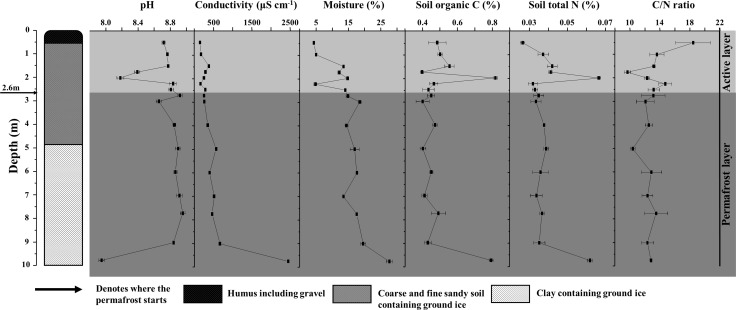
Schematic diagram of the permafrost core and the associated physiochemical characteristics of different-depth samples.Error bars represent means ± the standard error (n = 3).